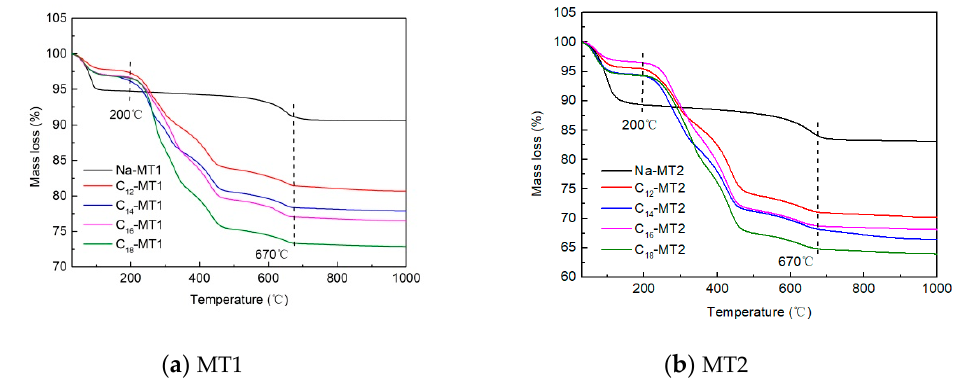
Figure 4. Thermogravimetric (TG) curves of Na-MT and prepared organo-MT, ( a ) MT1; ( b ) MT2. Table 5. The mass loss of organo-MT at different temperature range (wt %).